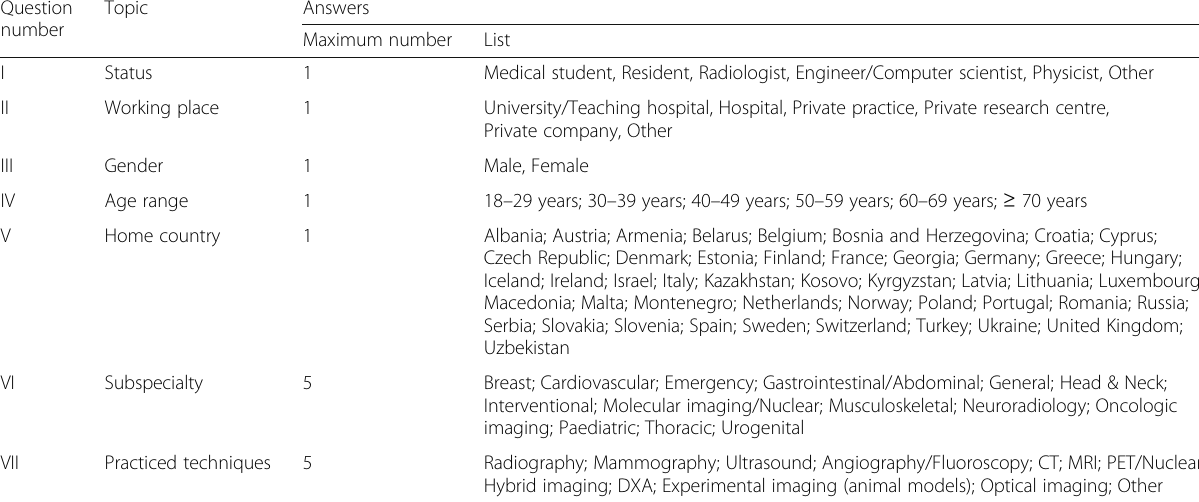
Table 1 Multiple-choice questions related to respondent ’ s age, sex, radiology subspecialty, most frequently practiced techniques and working status, type of institution, and